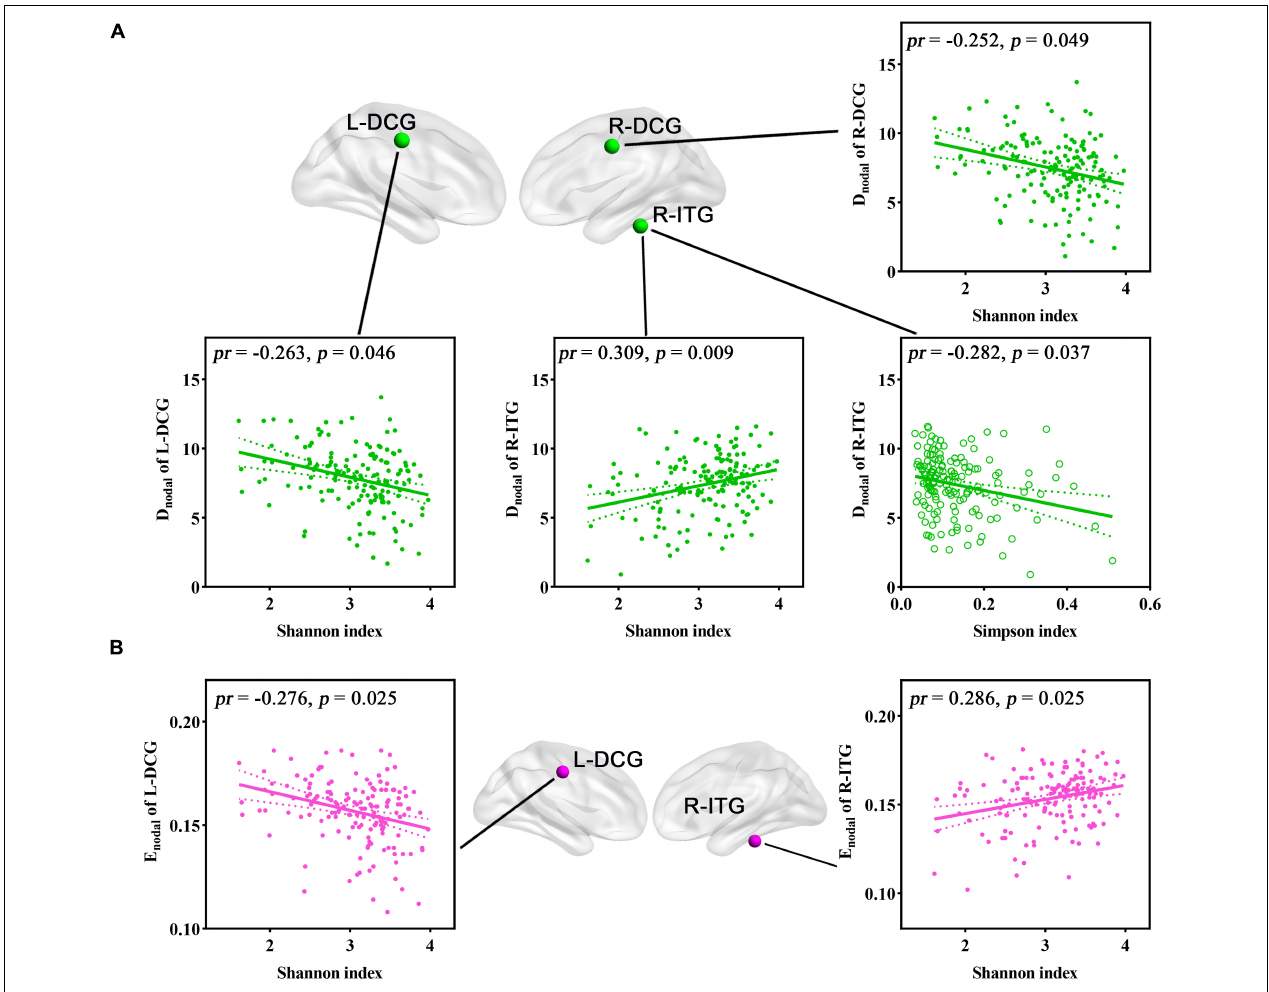
FIGURE 5 | (A,B) Correlations between gut microbial diversity and regional topological metrics of FC. Spatial maps show the significantly related nodes (i.e., brain regions). DCG, median cingulate and paracingulate gyri; D nodal , nodal degree centrality; E nodal , nodal efficiency; FC, functional connectivity; ITG, inferior temporal gyrus; L, left; pr , partial correlation coefficient; R,